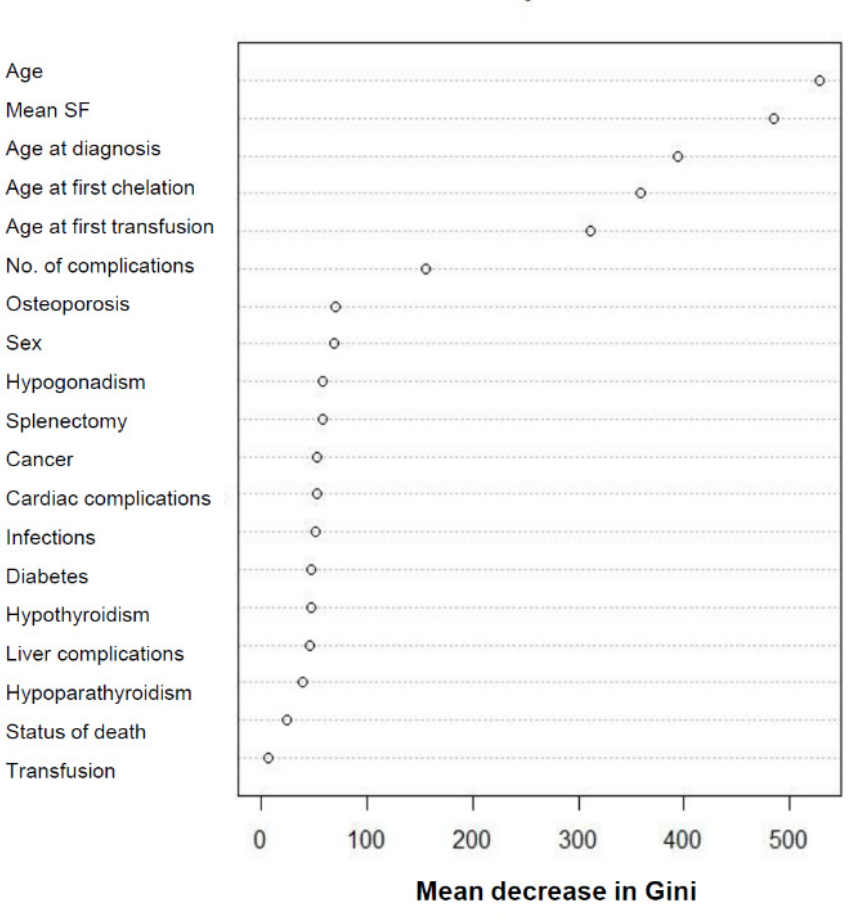
Figure 1. Variable importance plot of indicators of phenotype severity (IPhS) in β -thalassemia from unsupervised random forest (RF) analysis. SF, serum ferritin.